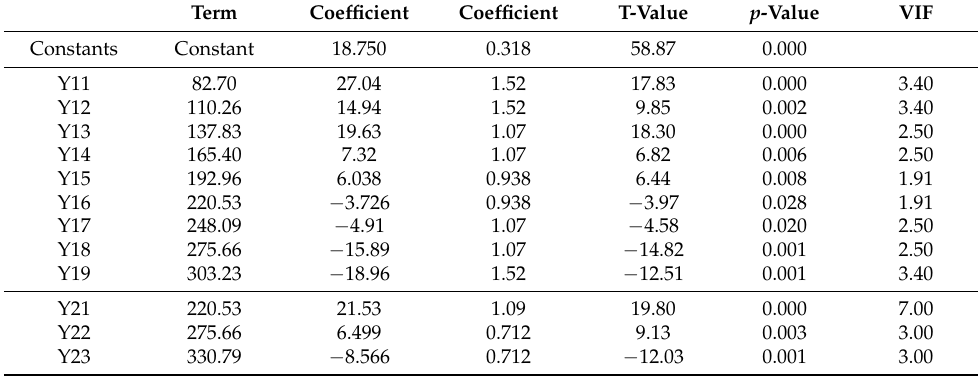
Table 8. Coefficients from linear regression.